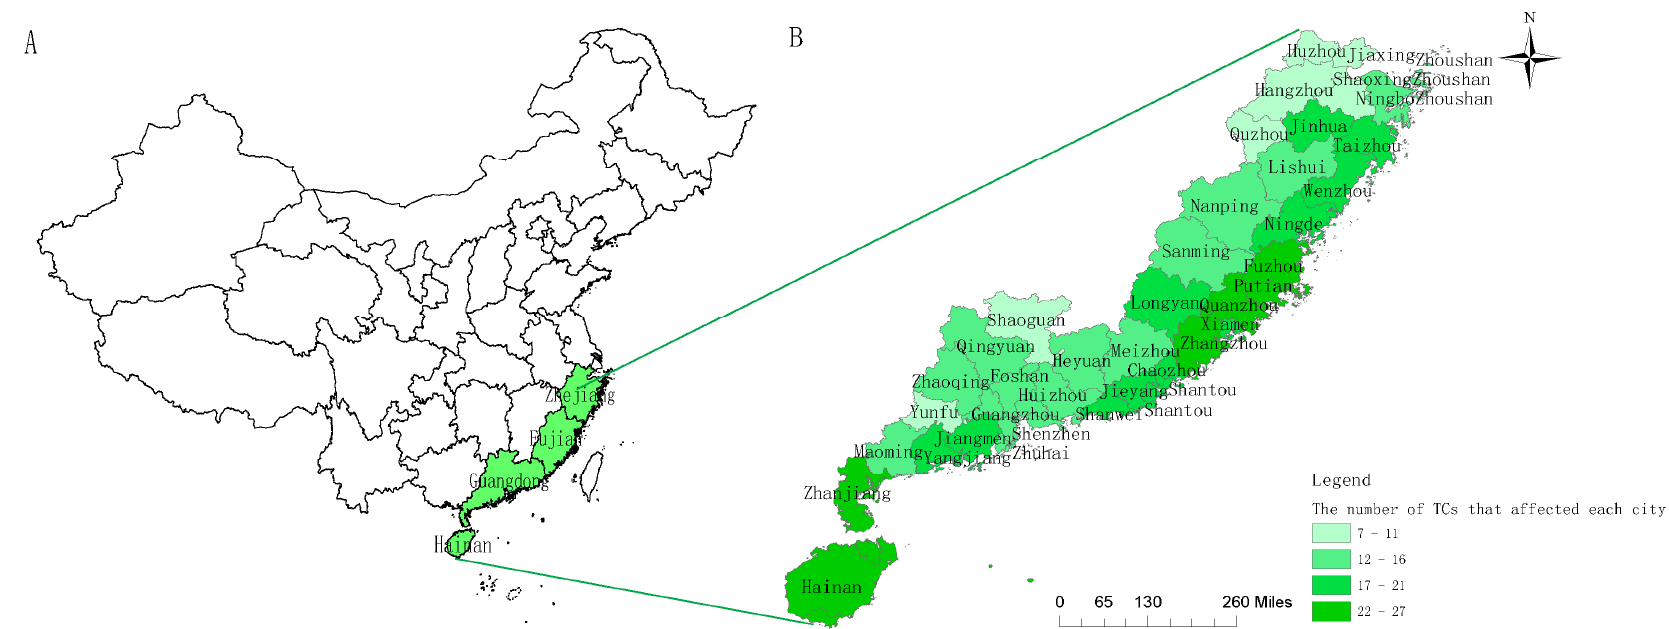
Figure 1. Study areas affected by TCs (tropical cyclones) ( A ) and the number of TCs (cyclone events) that affected each city ( B ), China, 2005–2011.